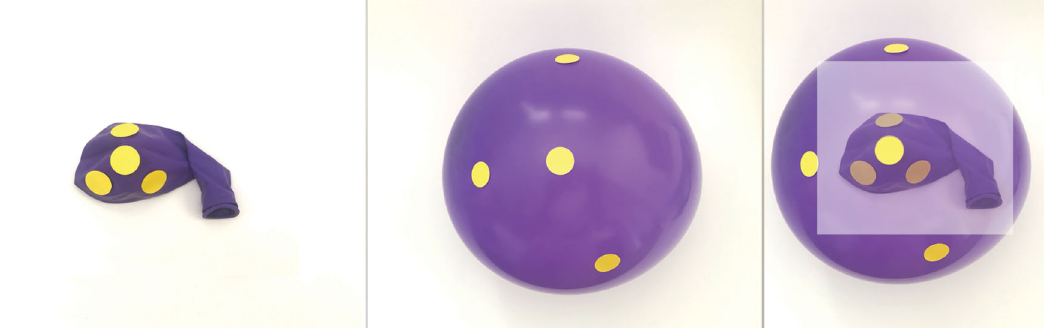
FIG. 24. Expanding balloon with rigid dots. Notice that in this physical demonstration of the analogy, the concept is slightly better communicated. The galaxies themselves are not expanding. Teacher scaffolding is still required to make sense of a potential question that will often arise “ What is the Universe expanding into? ” . Image credit: Saeed Salimpour.